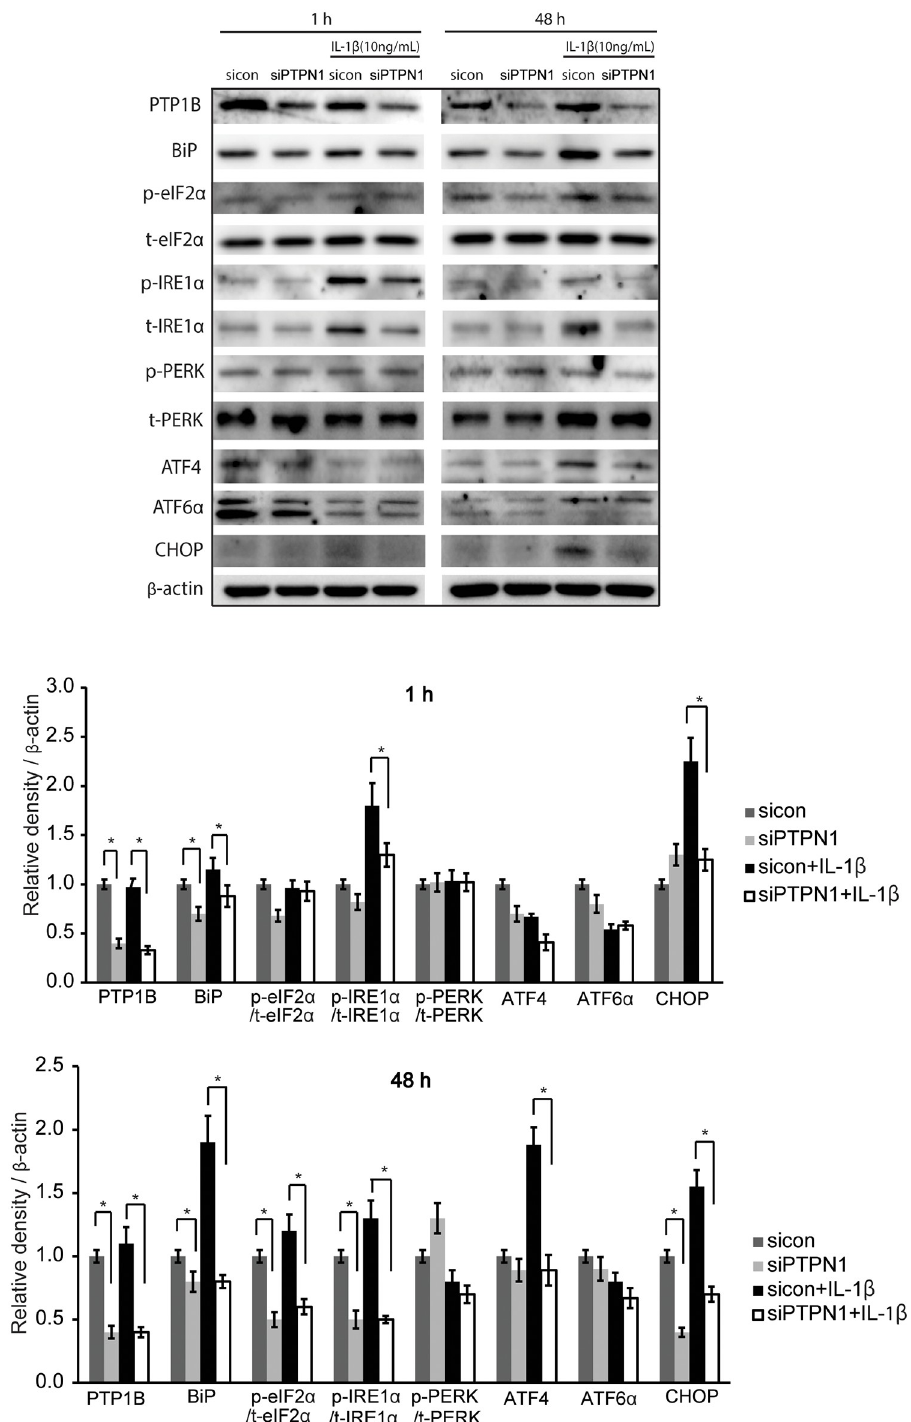
Fig 5. Role of PTP1B suppression on ER stress. GO fibroblasts were transfected with sicontrol or siPTPN1 for 24 hours and exposed to IL-1 β (10 ng/mL) for 1 hour or 48 hours. The GO fibroblasts were lysed and proteins related ER stress such as BiP, CHOP, ATF4, ATF6 α , phosphorylated and total eIF2 α , IRE1 α , and PERK were analysed by western blot. Experiments were performed in three GO cells from different individuals. (A) Representative gel images are shown. (B,C) Data in the columns represent the mean density ratio ± SD by densitometry normalised to the level of β - actin in the same sample for 1 hour and 48 hours, respectively. Differences between sicontrol and siPTPN1 are indicated ( � p < 0.05). See S3 Fig for uncropped